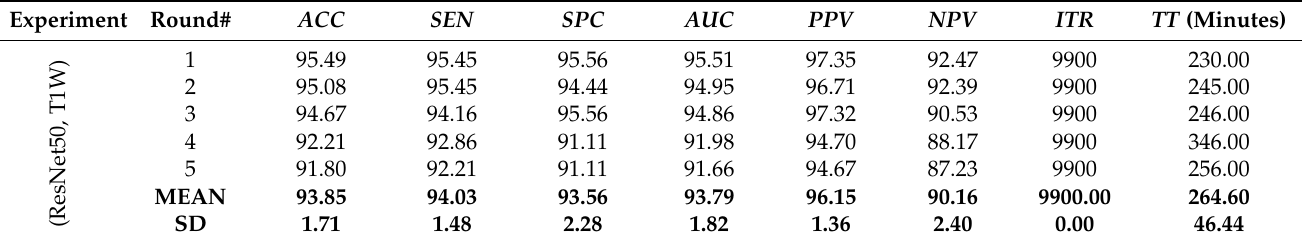
Table A7. Test results of five-folds of experiment (ResNet50, T1W).